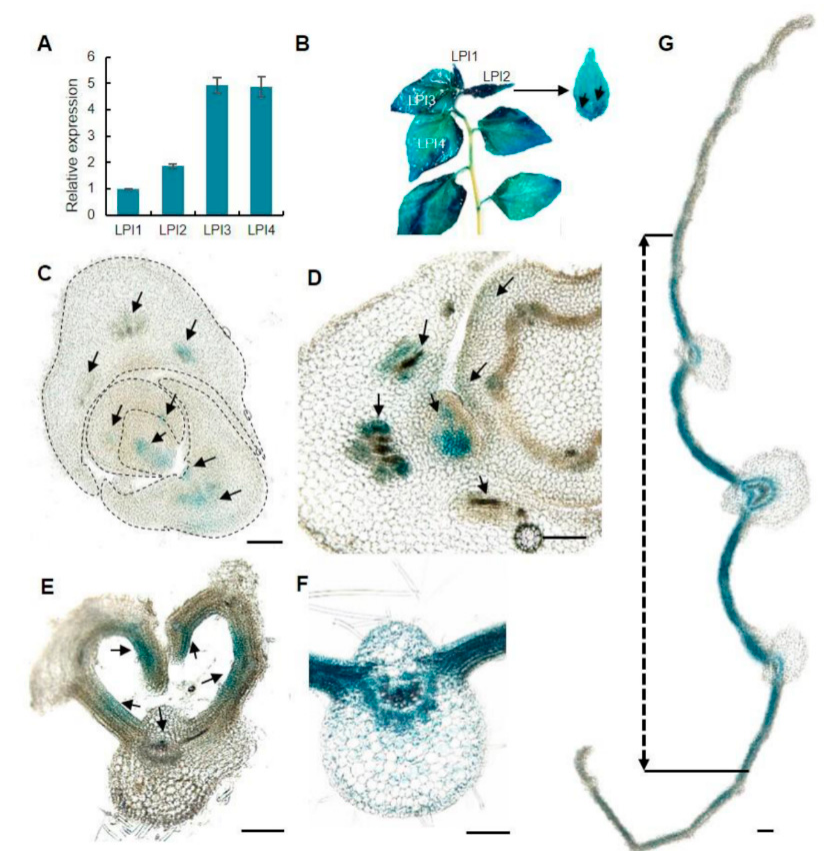
Figure 1. Expression patterns of PagKNAT2/6b in poplar leaf. ( A ) The expression profile of PagKNAT2/6b during leaf development from leaf plastochron index 1 (LPI1) to LPI4 by qRT-PCR. ( B ) GUS staining of P PagKNAT2/6b ::GUS transgenic poplar in LPI1 to LPI4, and LPI2 in a magnified view. ( C , D ) Transverse sections of the shoot apical meristem (SAM). ( E ) GUS signals in unexpanded leaf LPI1. ( F ) GUS signals in the main veins of LPI2. ( G ) GUS signals in the middle of LPI3, and the arrow shows the medial region of LPI3. Experiments were repeated three times and the representatives were shown. The salient signal is indicated with arrows. Bar = 100 μ m.